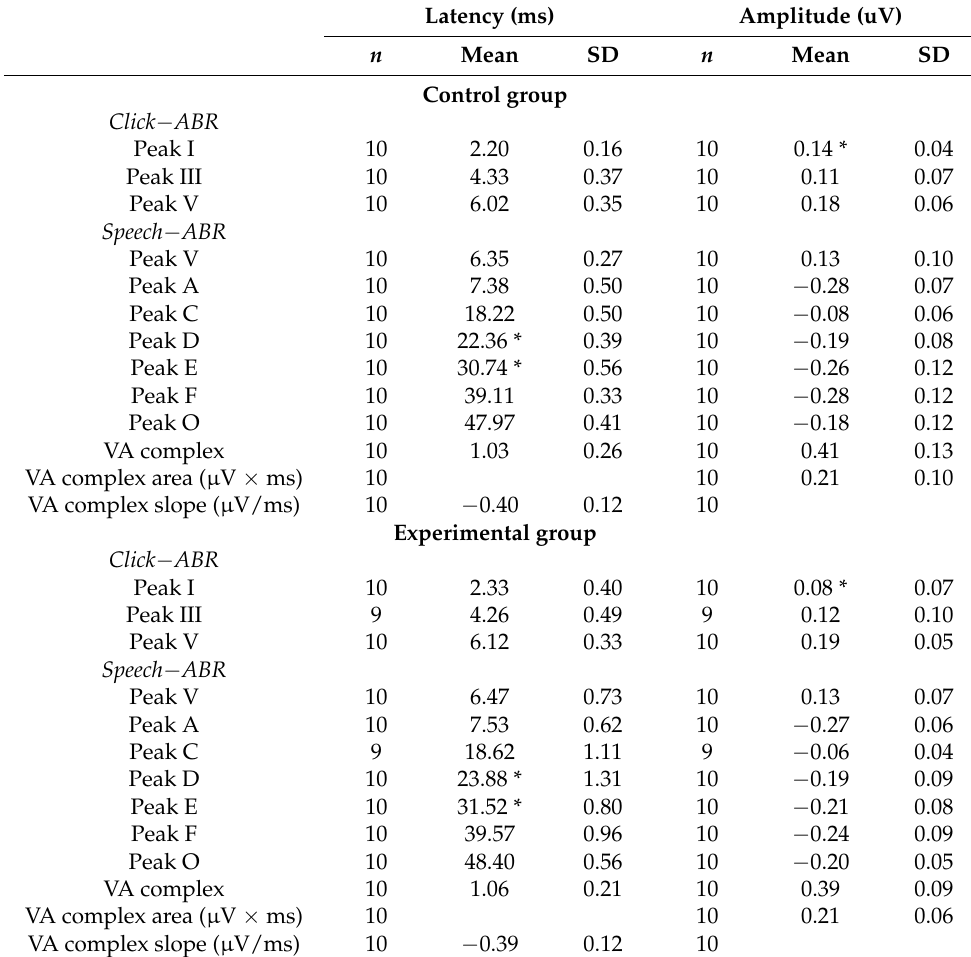
Table 3. Latency and amplitude of click- and speech-ABR collected in children of the experimental and control